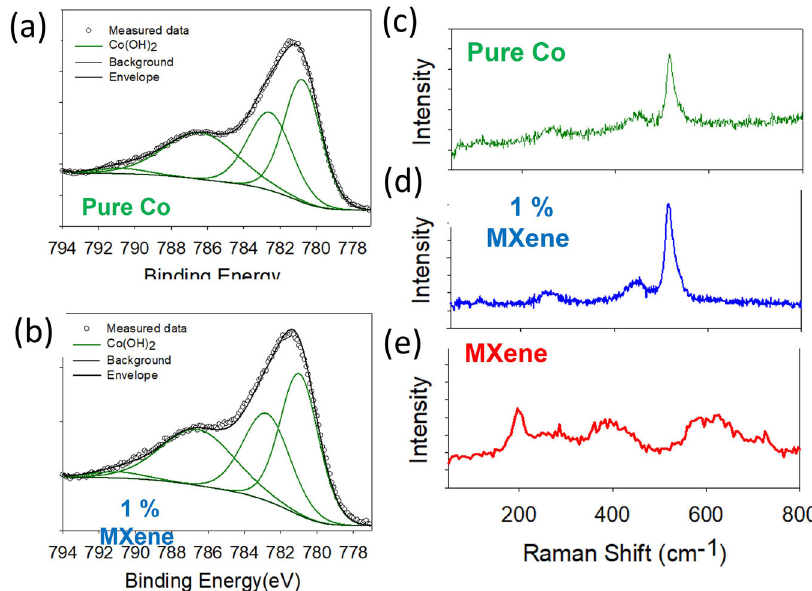
Fig. 2 Structural characterization. X-ray photoelectron spectroscopy high resolution Co2 p 3/2 core level for ( a ) pure Co, ( b ) 1% MXene. Raman spectra (using a 532 nm laser) of ( c ) pure Co, ( d ) 1% MXene and ( e ) pure